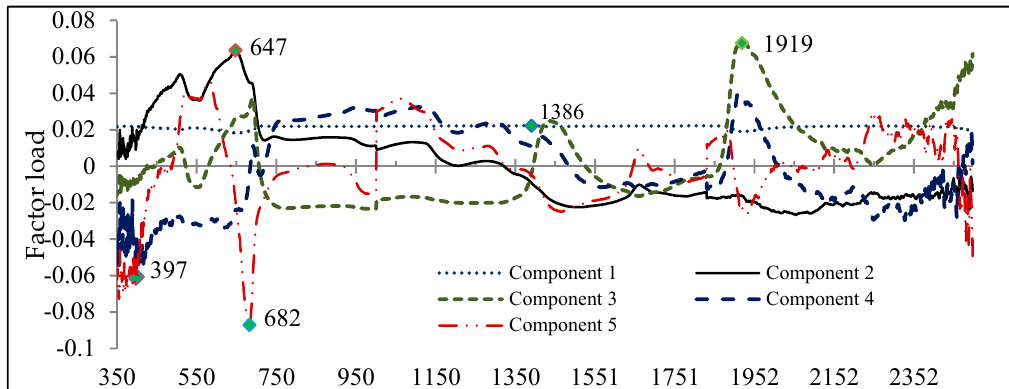
Figure 6. The loading of wavelengths in the first five extracted components by PLS.